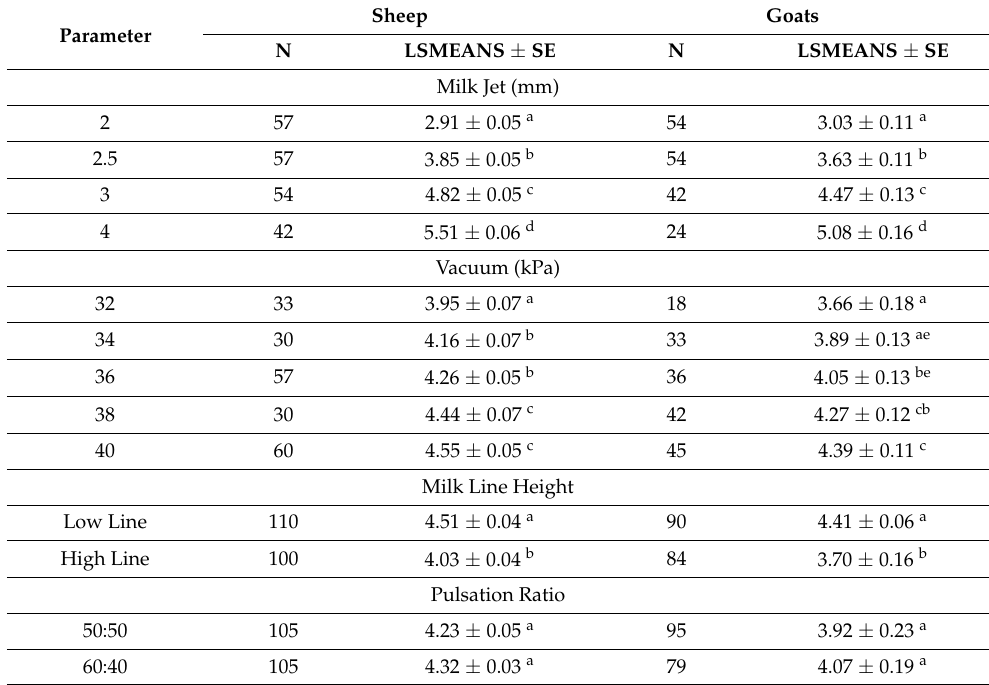
Table 2. Some factors influencing the performance of the milking machine in sheep and goats.